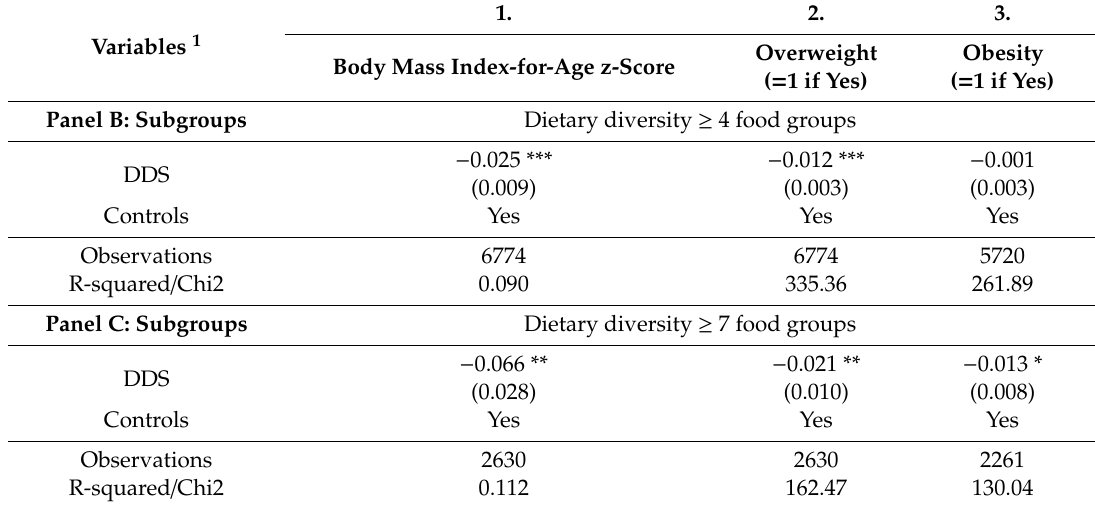
Table 6. Heterogeneity in the correlation between DDS and nutrition outcomes by gender and age.